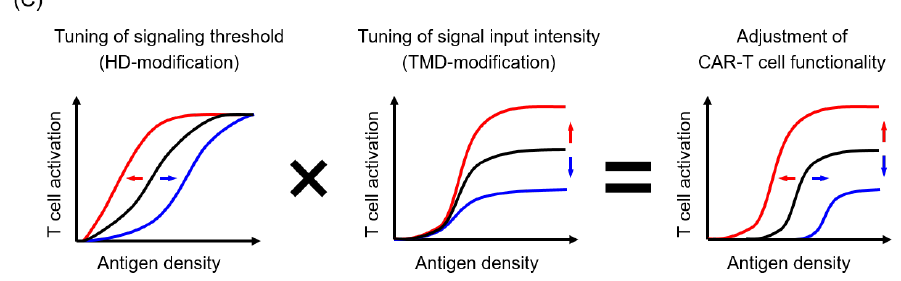
Figure 5. Role of hinge domain (HD) and transmembrane domain (TMD) in CAR. ( A ) Role of HD in the expression modality and membrane transport efficiency as well as CAR signaling threshold. ( B ) Role of TMD in CAR intracellular dynamics and surface expression stability. ( C ) Strategy to adjust CAR-T cell function by modifying CAR HD/TMD.